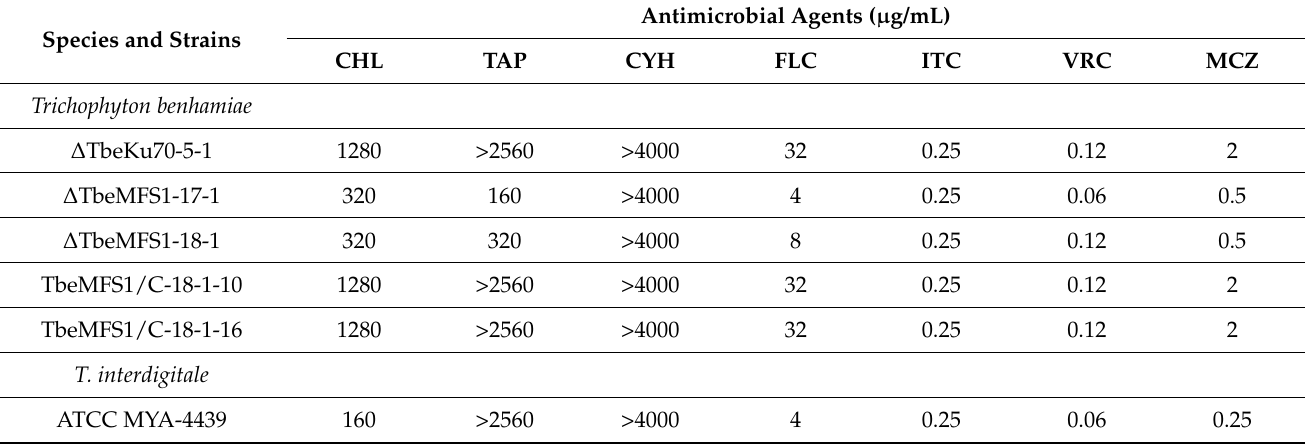
Table 2. Susceptibility to antimicrobial agents of T. benhamiae MFS1 -lacking mutants and revertants. Antimicrobial Agents ( µ Species and Strains